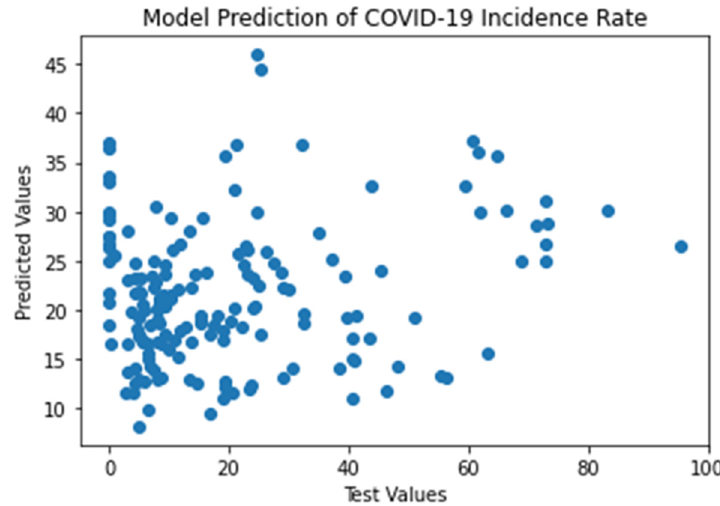
Figure 4. A scatter plot of test values vs. predicted values over Mississippi 22 January 2020 to 4 August 2021.